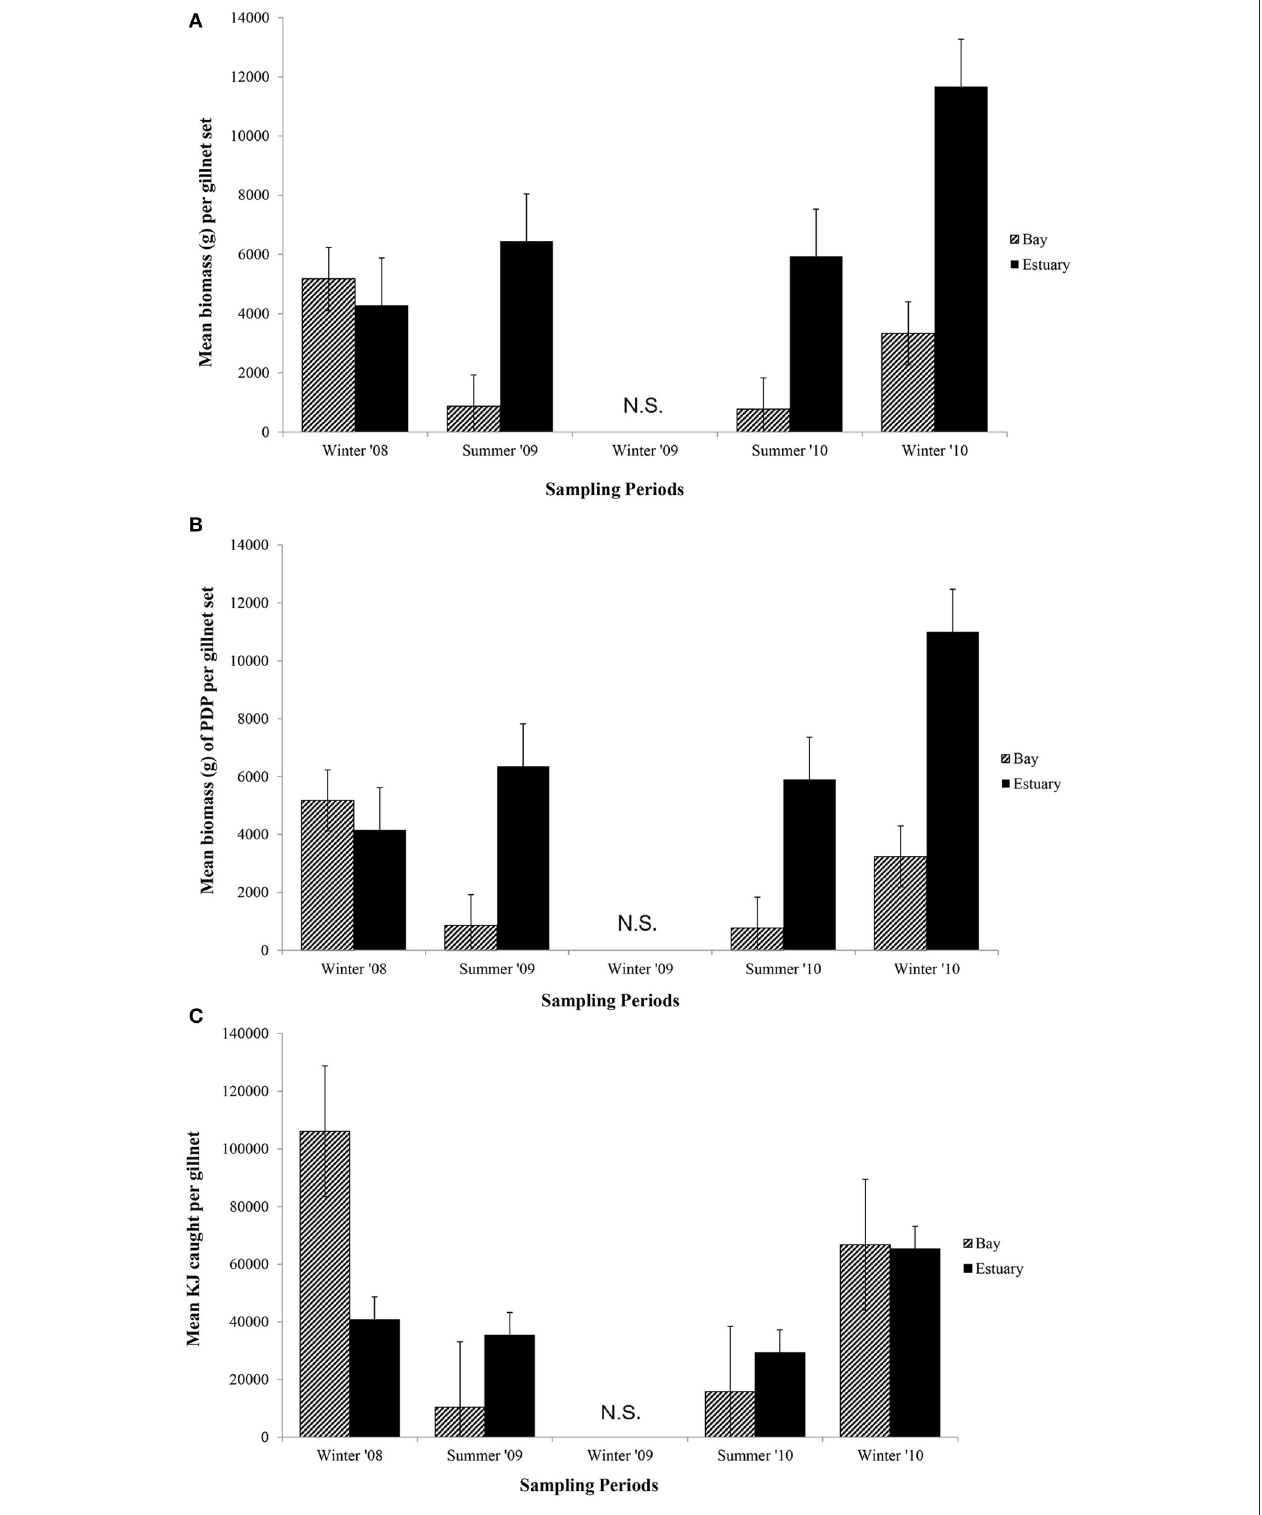
FIGURE 5 | Mean biomass ( ± 1 SE) caught per gillnet set for (A) total biomass; (B) biomass of PDP; and (C) KJ per gillnet in the Bay, and Estuary. N.S. = Not Sampled.